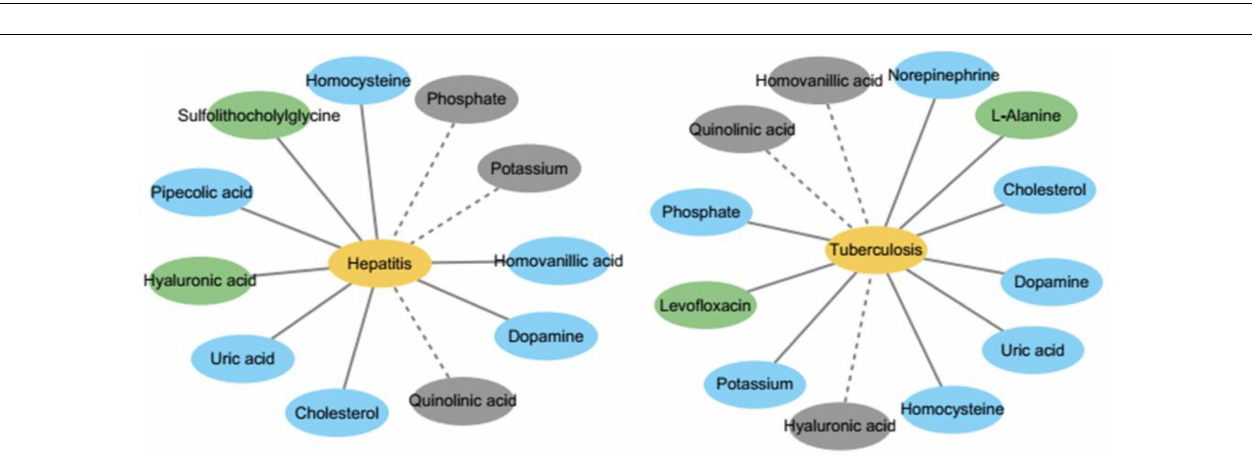
FIGURE 6 | Comparison results about fivefold cross validation. (A) Different methods for comparation. (B) The combination of different parts in SSABCMDA for comparation.